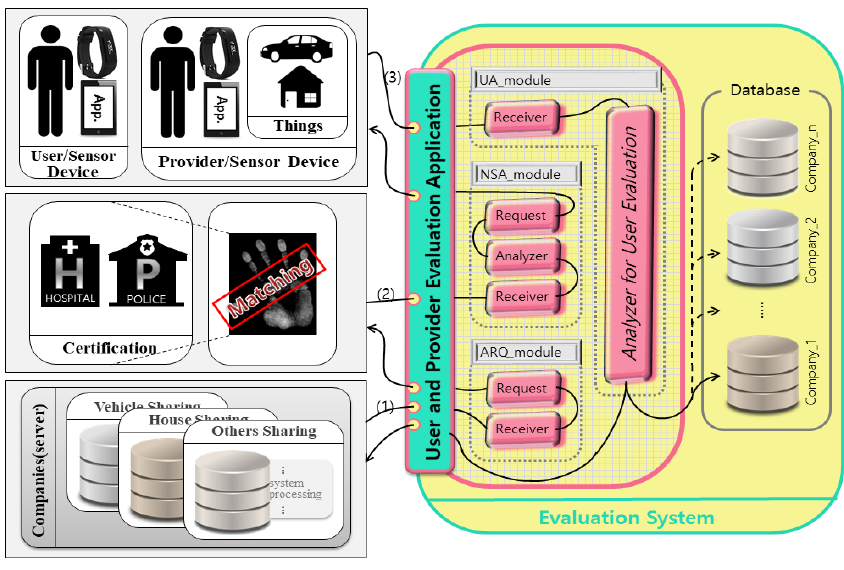
Figure 10. Internal structure of the user’s reliability measurement system.